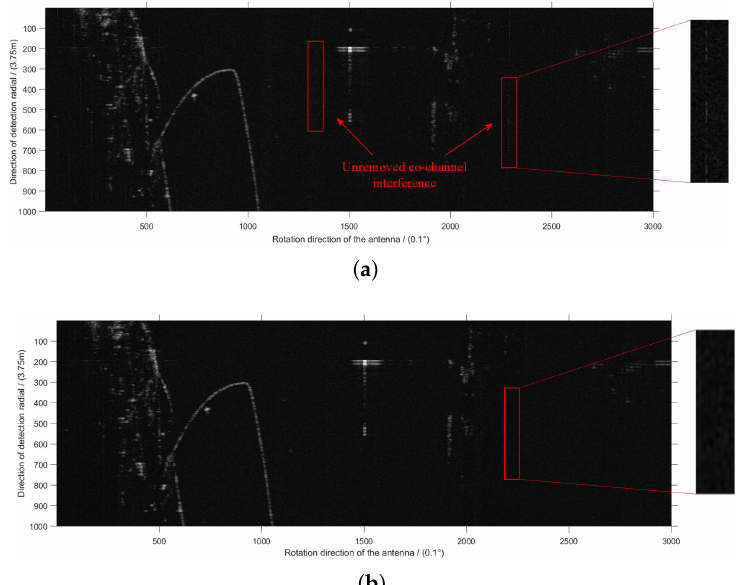
Figure 5. Comparison of processing results. ( a ) Results of adaptive median filtering algorithm, ( b ) results of the proposed